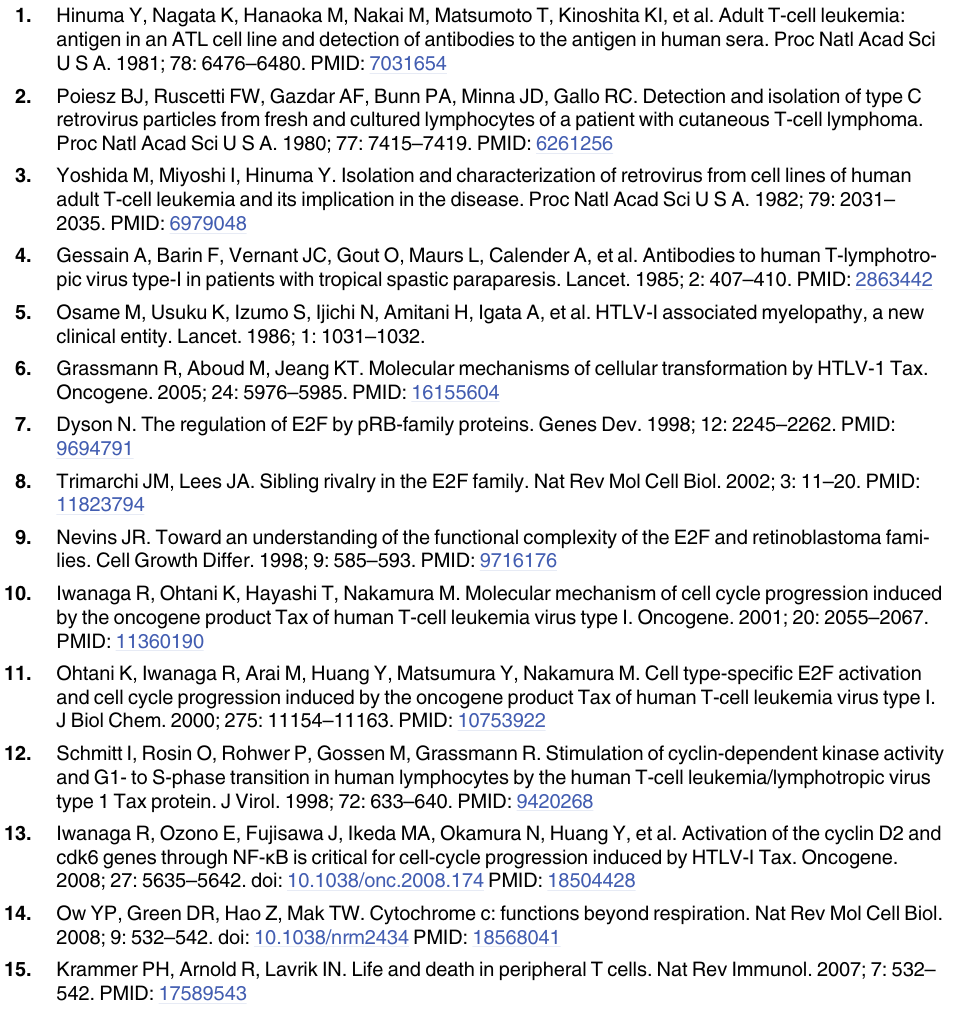
S1 Table. Summary of PCR